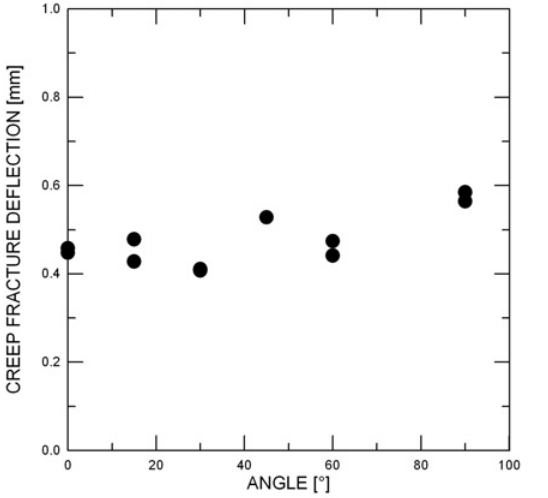
Figure 7. Dependence of the fracture deflection on sample